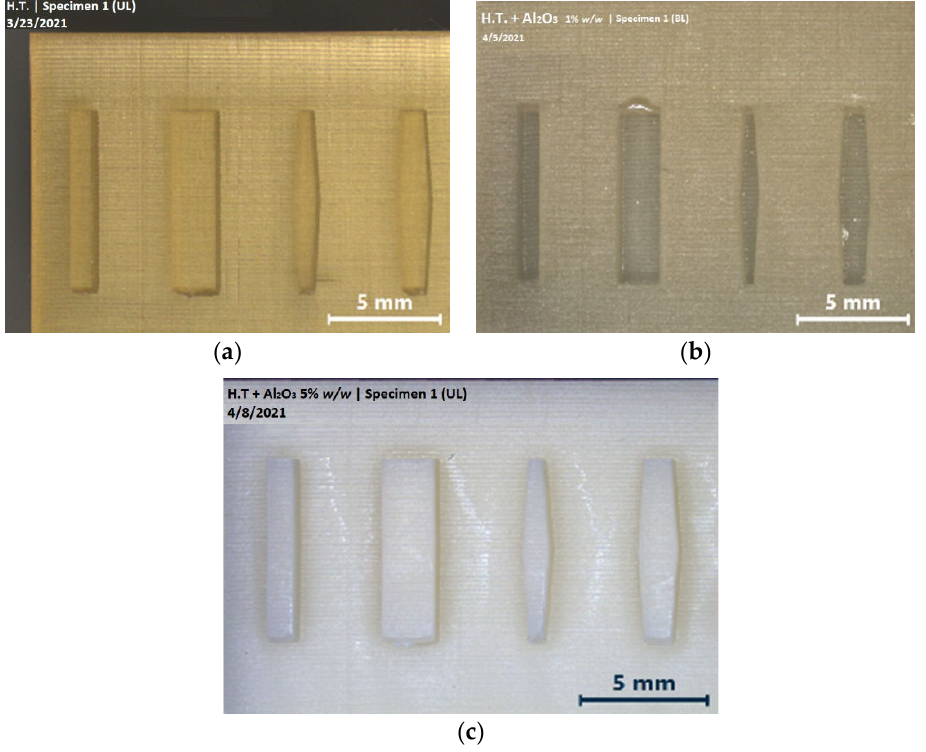
Figure 5. Indicative images of as-printed specimens for feature inspection using stereoscope imaging for measuring basic dimensions and tolerances for 30 × 50 × 3 mm nominal dimensions; ( a ) for pure resin (FormLabs High Temp—HT) prior to mixing with ceramic particles; ( b ) for resin with low content of ceramic particles (Al 2 O 3 ); ( c ) for selected resin (FormLabs High Temp—HT) with increased content of ceramic particles (Al 2 O 3 ). Table 3. Measurement analysis for outward features.